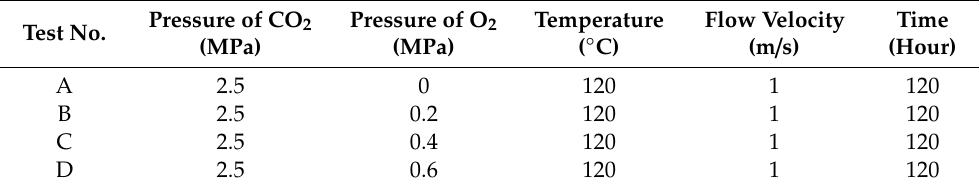
Table 2. Experimental